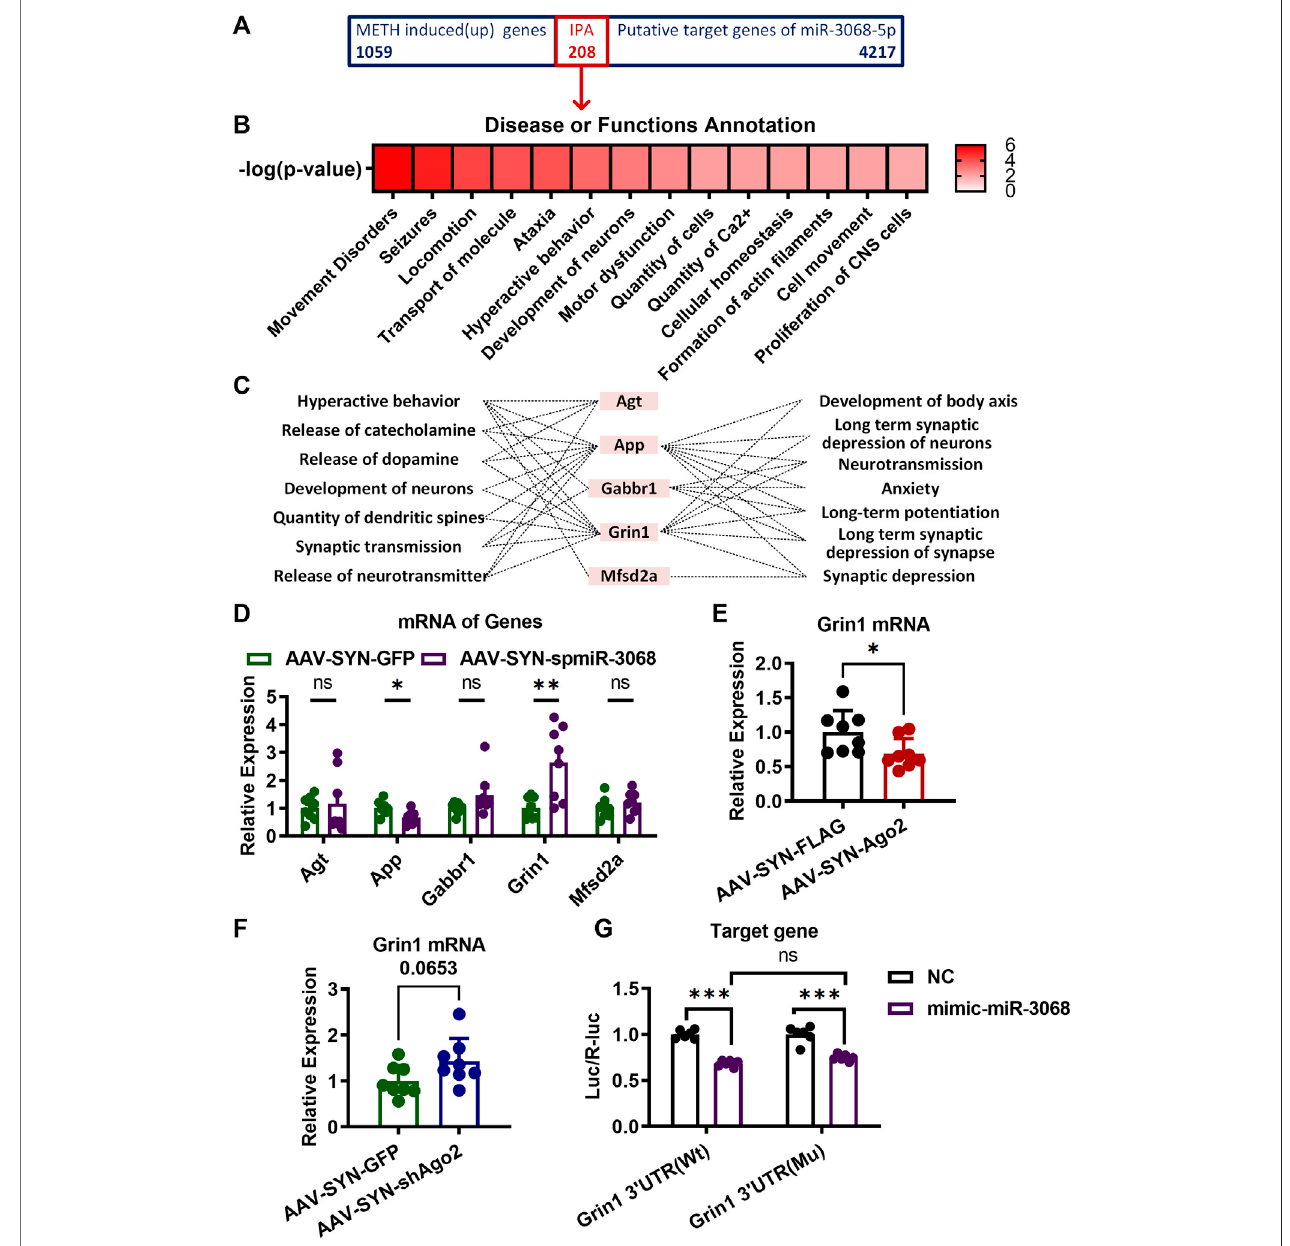
FIGURE4| TargetgenesofmiR-3068-5pinNAcofmiceinvolvinginMETHsensitization. (A) Atotalof208overlappinggenesbetweentheMETH-inducedgenesin ourpreviousstudy (https://www.ebi.ac.uk/arrayexpress/, E-MTAB-2843) and the predicted targetgenesofmiR-3068-5p were identi fi ed andsubjected toIPAanalysis. (B) Identi fi cation of the main neurological dysfunctions of the 208 genes identi fi ed from (A) . (C) IPA analysis identi fi ed fi ve overlapping genes from (A) relevant to hyperactive behavior, release of catecholamine, release of dopamine, development of neurons, quantity of dendritic spines, synaptic transmission, release of neurotransmitters, development of the body axis, long-term synaptic depression of neurons, neurotransmission, anxiety, long-term potentiation, long-term synaptic depression of synapses, and synaptic depression. (D) mRNA expression of the fi ve predicted target genes of miR-3068-5p relevant to locomotion following miR-3068- 5p sponging in the NAc of METH-sensitized mice. (E, F) Graphs show the expression of Grin1 mRNA upon overexpression (E) or knockdown (F) of Ago2. Student ’ s t -test: * p < 0.05 and ** p < 0.01 compared to the AAV control group. The data are presented as the mean ± SEM, n (cid:2) 6 – 8. (G) Graphs showing the dual-luciferase activities upon transfection of Grin1 Wt or mutant (Mu) expression conducted alone (NC) or by cotransfection with mimic-miR-3068-5p. Two-way ANOVA: *** p < 0.001 comparedtothecorrespondingNCgroup.Thedataarepresentedasthemean ± SEM, n (cid:2) 6.NAc,nucleusaccumbens;METHsensitization,METH-inducedlocomotor sensitization; IPA, Ingenuity Pathway Analysis.